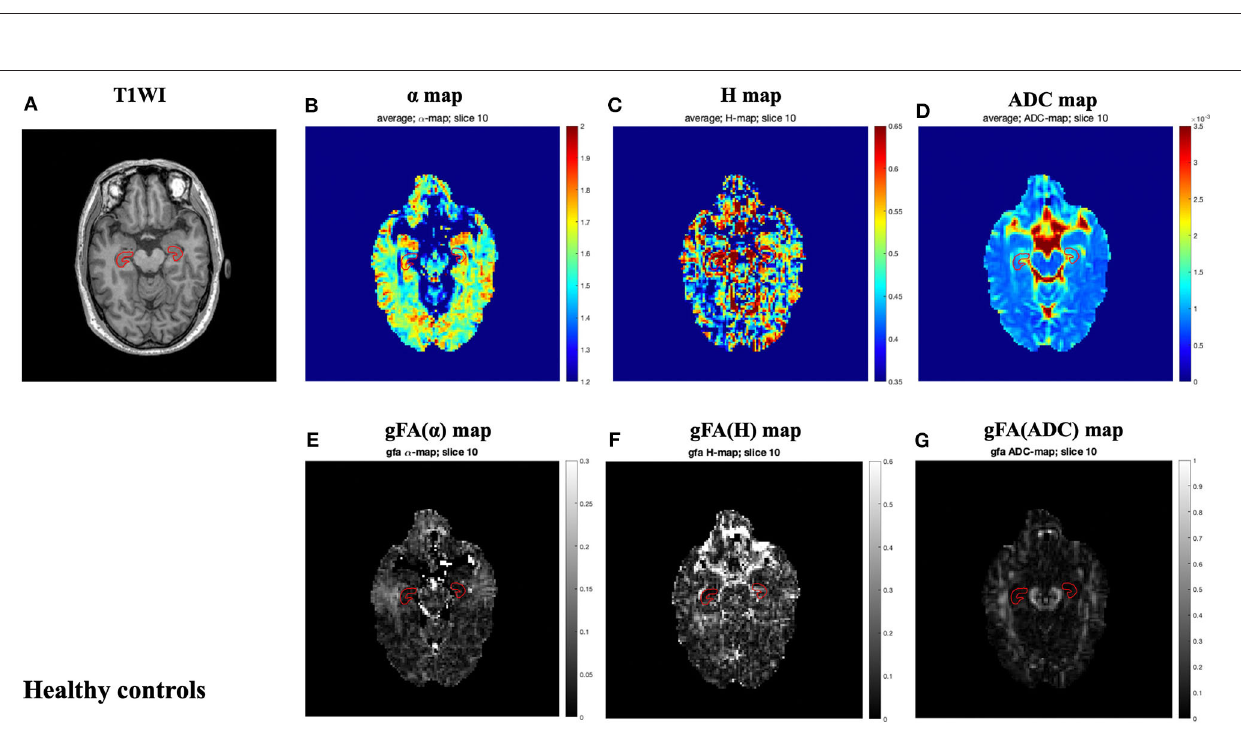
FIGURE 2 | A 58-year-old male patient with AD. Top row: T1-weighed image (A) and directionally averaged maps of α , H , and ADC [ (B–D) , respectively]. Bottom row: generalized fractional anisotropy (gFA) maps of α , H , and ADC [ (E–G) , respectively]. The bilateral hippocampus is shown with red outlines in all maps. AD, Alzheimer’s disease; ADC, apparent diffusion coefficient; gFA, generalized fractional anisotropy.